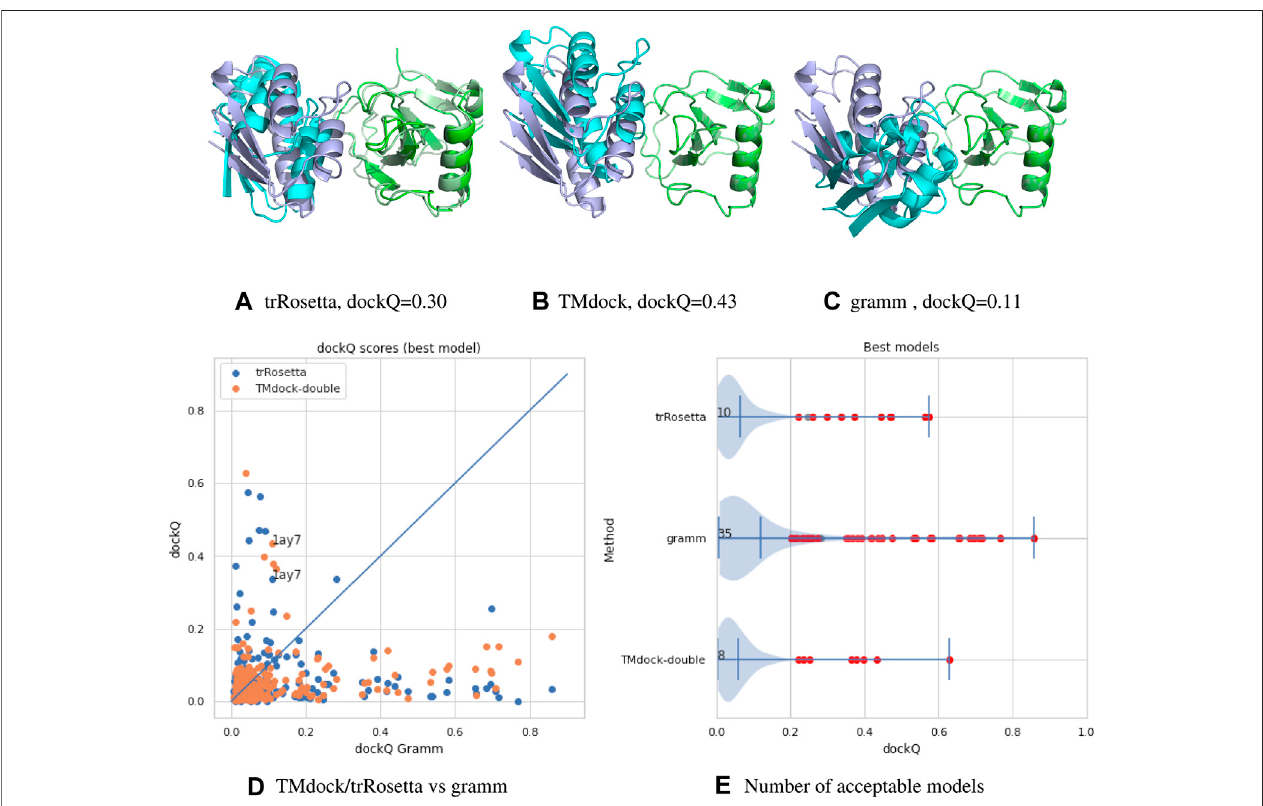
FIGURE1|(A – C) comparisonofmodelsfortarget1ay7(themodelwiththebestmedianscore)generatedbythreedifferentdockingprotocols,trRosetta(contact- based docking), TMdock (template-based docking) and gramm (free docking). All superpositions is done on the fi rst protein chain (in green). The native pdb structure is shown in lighter colors. For trRosetta both chains are shown as they are both folded, while for the other methods the fi rst chain is identical to the native structure and thereforenotseen. (D,A) Acomparison ofdockingqualities for218heterodimericproteins pairsfrom thedockground4.3dataset usingdockQ (Basuand Wallner, 2016)forthethreemethods.AdockQscoreof0.2orhigherisoftenusedasanindicationforanacceptabledockingmodel.Thenumberrepresentthenumberofmodels a certain method is better than the other two and that the quality is higher than this cutoff. For each target the score for the best of the top-10 ranked modes is